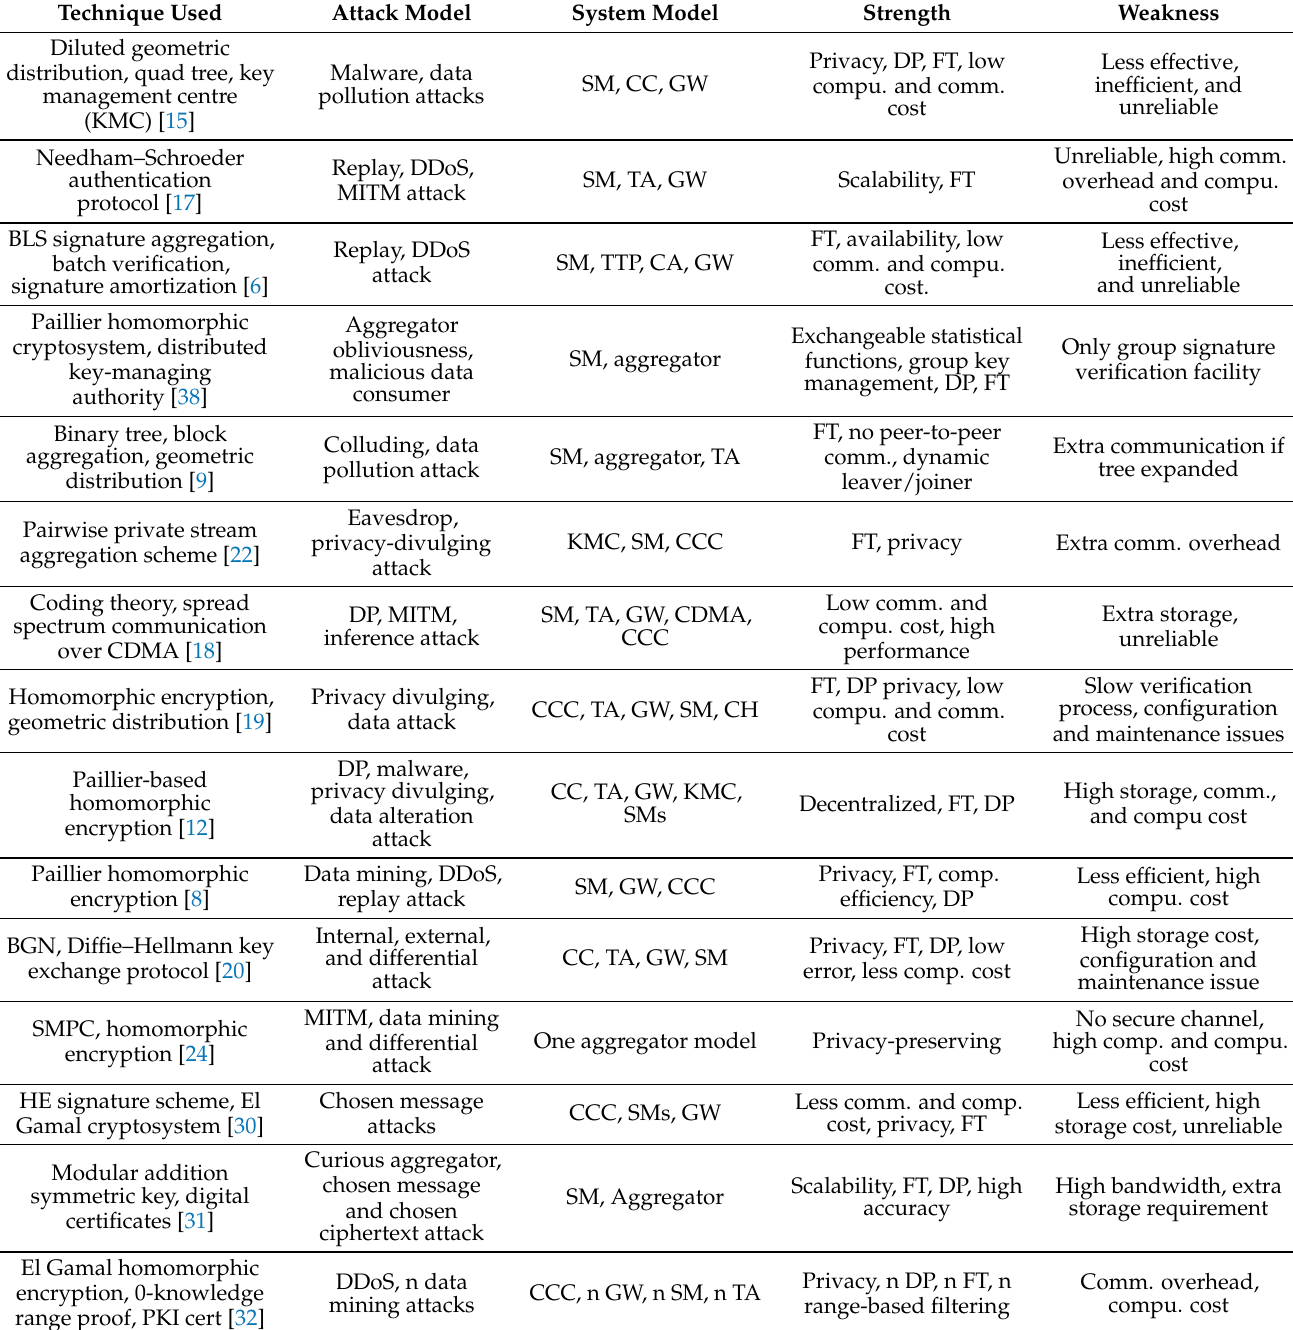
Table 1 gives an overview of existing FT aggregation schemes for the SG. Table 1. Overview of fault-tolerance schemes in smart